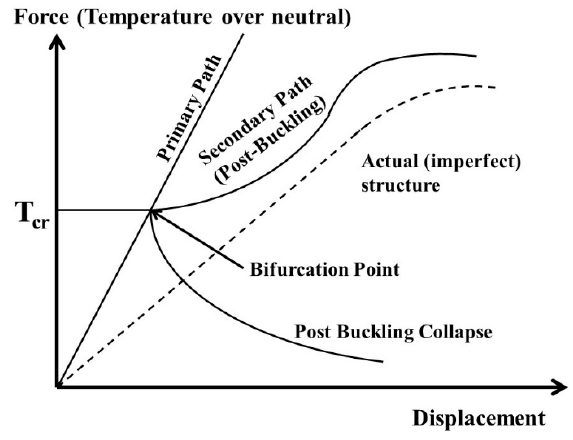
Figure 5. Linear bifurcation buckling path.